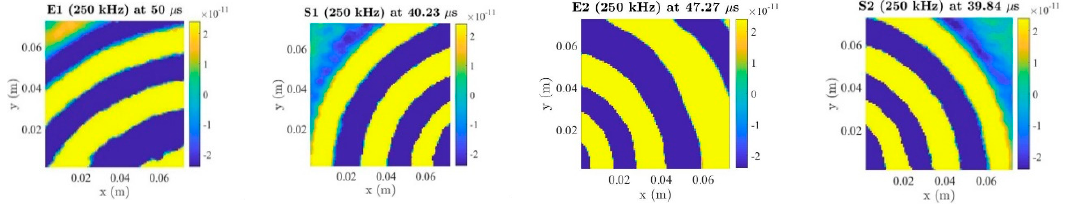
Figure 11. Laser Dropper Vibrometer (LDV) results for the blue ‐ tack (E: embedded, S: surface ‐ mounted).